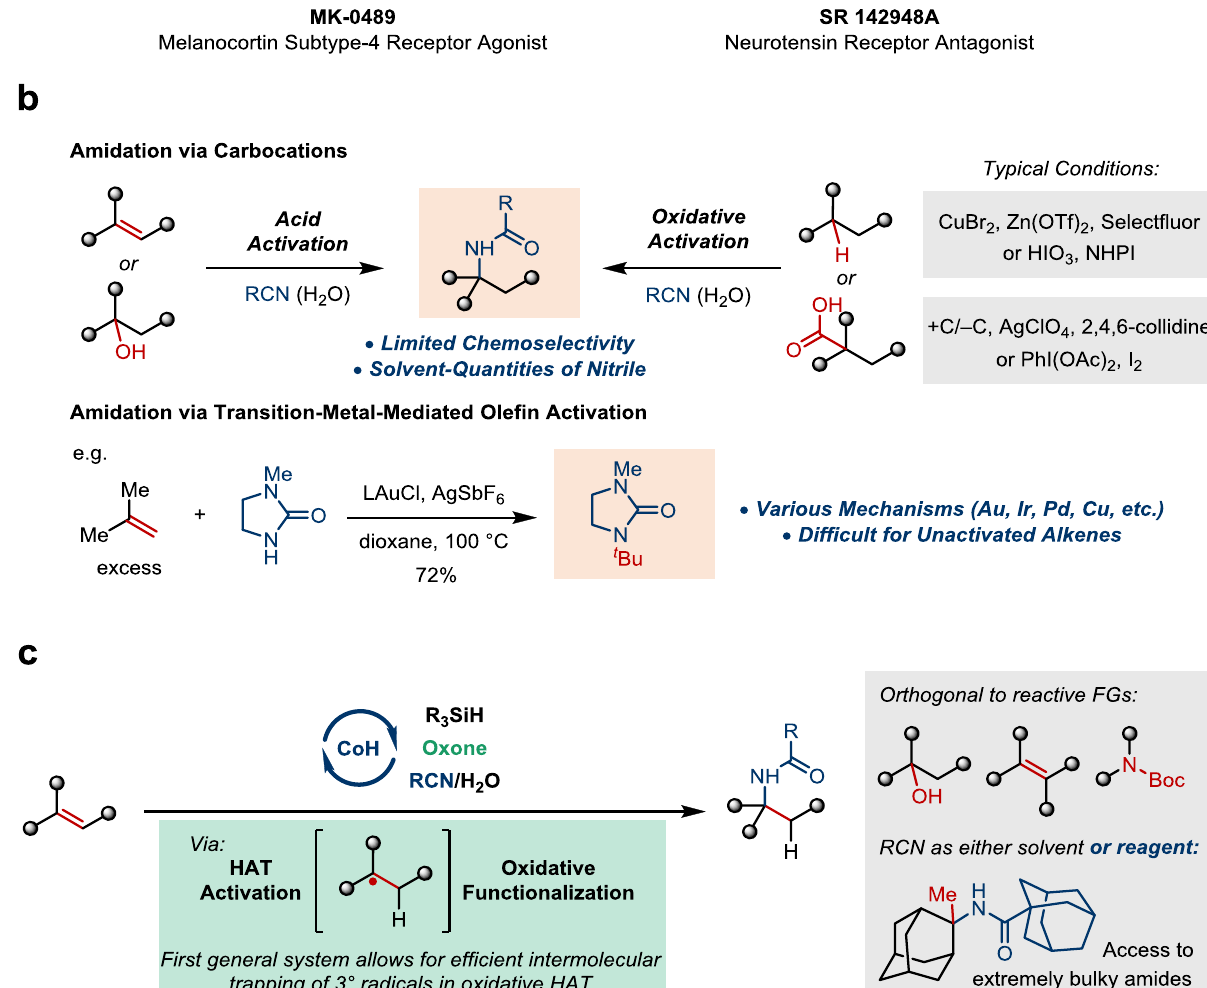
Fig. 1 Importance of α -tertiary amides and synthetic strategies. a Representative pharmaceutically relevant α -tertiary amides. b Previous work of α -tertiary amides synthesis. c Chemoselective Co-catalyzed oxidative